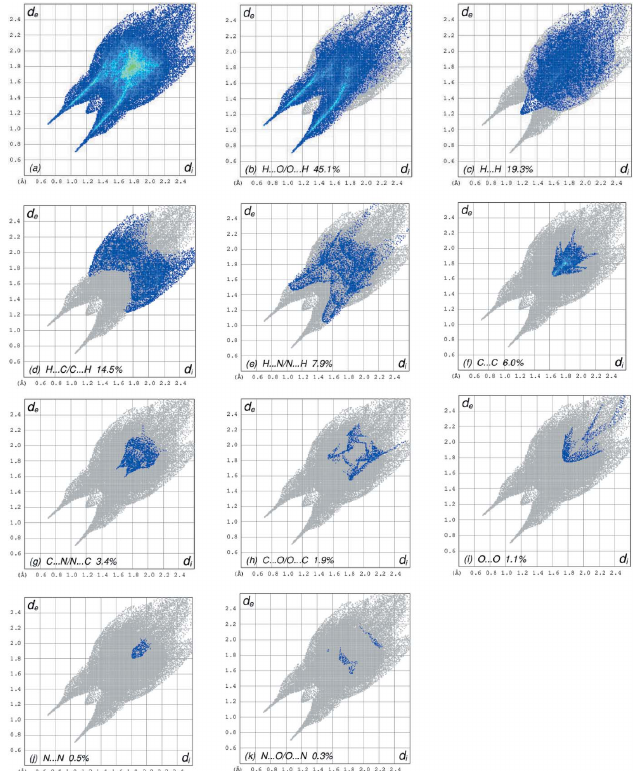
Figure 6 The full two-dimensional fingerprint plots for the title aroyl hydrazone Schiff base salt, showing ( a ) all interactions, and delineated into ( b ) H (cid:2)(cid:2)(cid:2) O/O (cid:2)(cid:2)(cid:2) H, ( c ) H (cid:2)(cid:2)(cid:2) H, ( d ) H (cid:2)(cid:2)(cid:2) C/C (cid:2)(cid:2)(cid:2) H, ( e ) H (cid:2)(cid:2)(cid:2) N/N (cid:2)(cid:2)(cid:2) H, ( f ) C (cid:2)(cid:2)(cid:2) C, ( g ) C (cid:2)(cid:2)(cid:2) N/N (cid:2)(cid:2)(cid:2) C, ( h ) C (cid:2)(cid:2)(cid:2) O/O (cid:2)(cid:2)(cid:2) C, ( i ) O (cid:2)(cid:2)(cid:2) O, ( j ) N (cid:2)(cid:2)(cid:2) N and ( k ) N (cid:2)(cid:2)(cid:2) O/ O (cid:2)(cid:2)(cid:2) N interactions. The d i and d e values are the closest internal and external distances (in A˚ ) from given points on the Hirshfeld surface